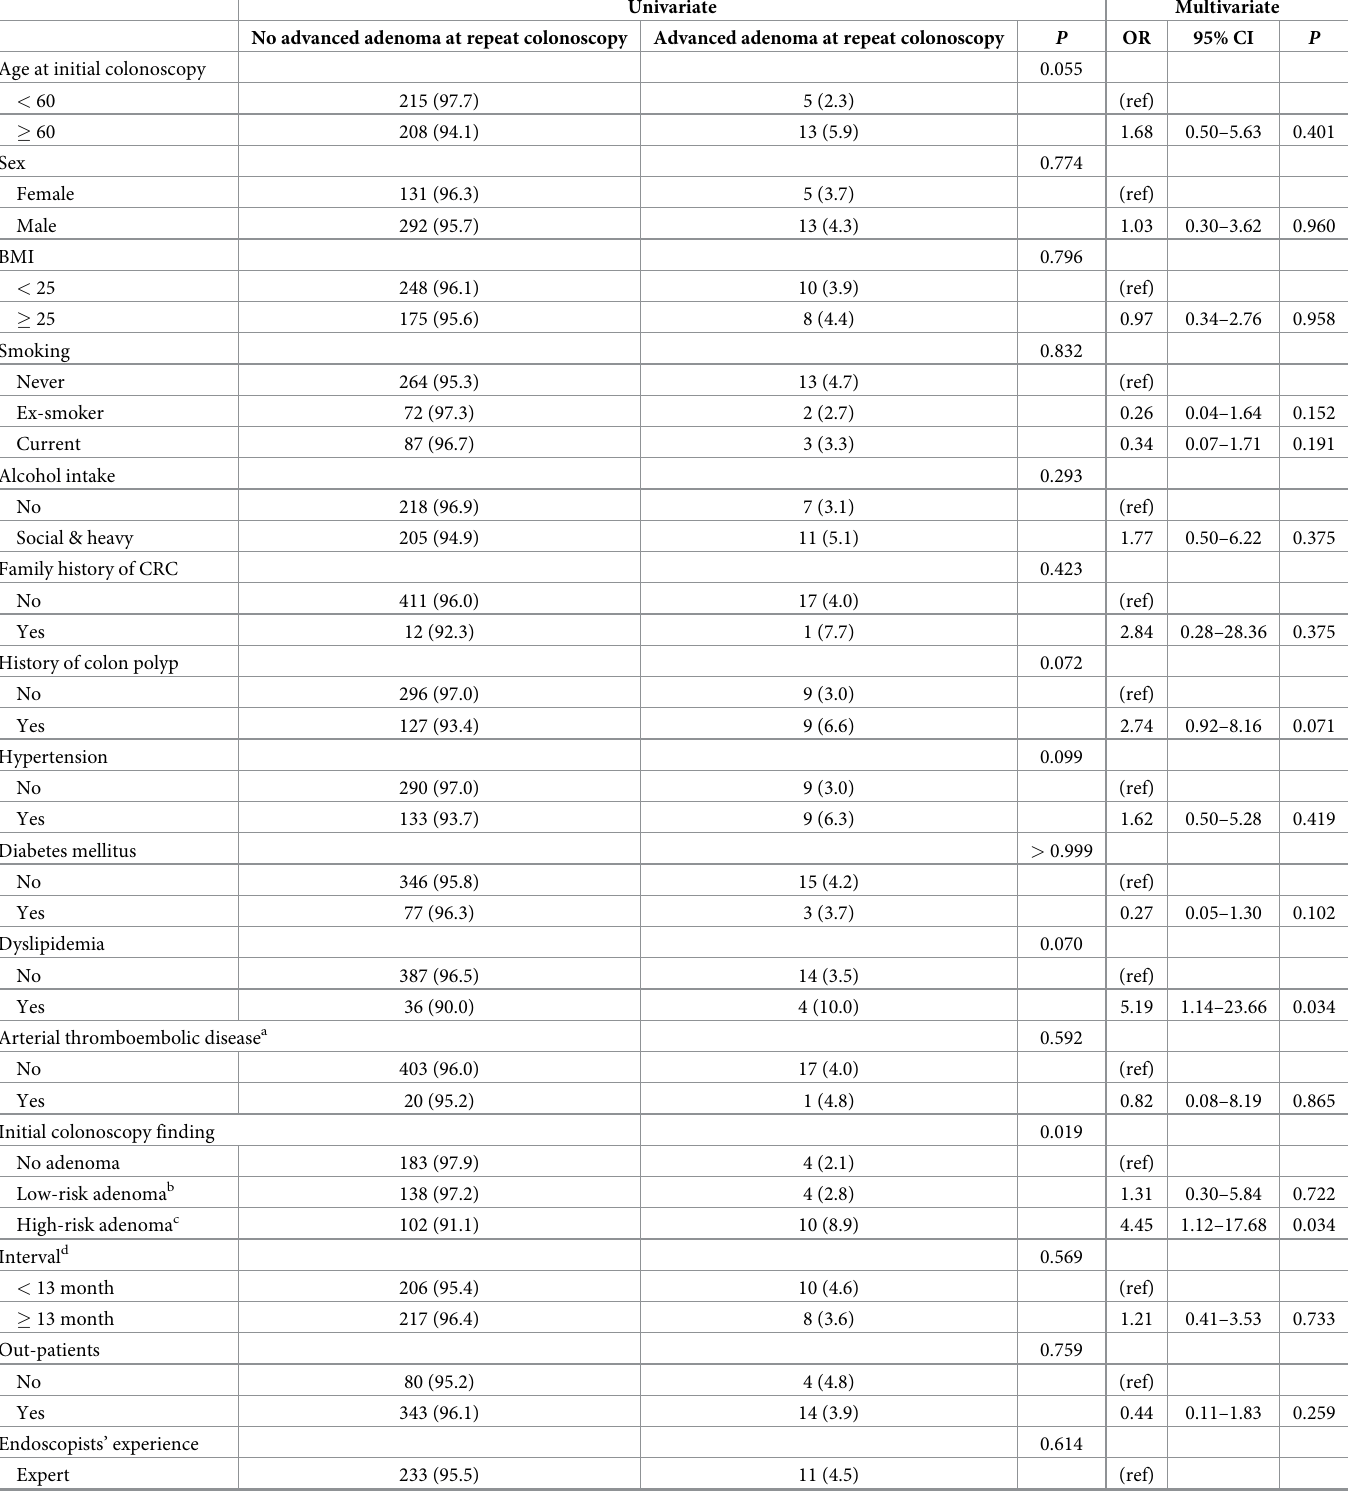
Table 4. Clinical factors at initial colonoscopy predictive of missed advanced adenoma of repeat